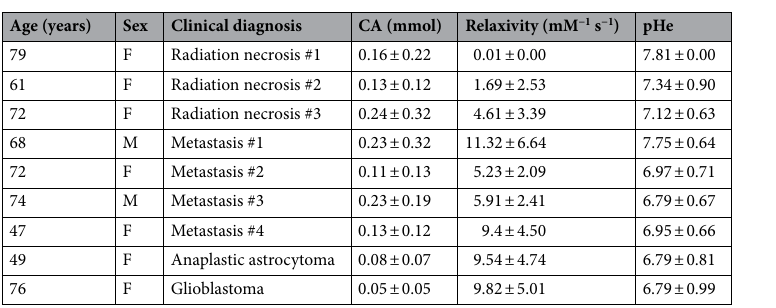
Table 2. Mean CA, relaxivity, and pHe values each of the